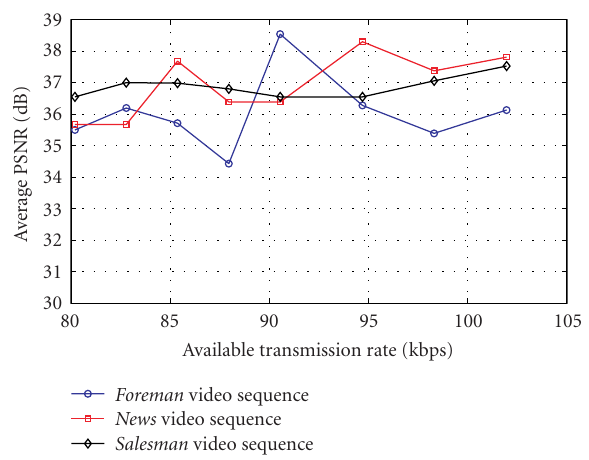
Figure 8: Average PSNR (in dB) as a function of available trans- mission rate (in kbps) for the “greedy-loss distribution” algorithm. Comparison between the proposed distortion model for all testing video sequences.